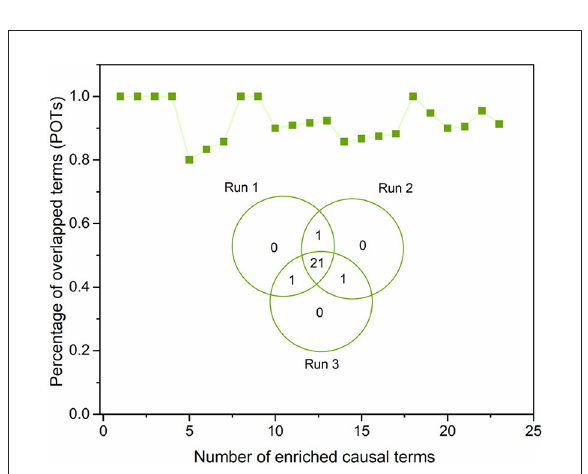
FIGURE7 Robustness evaluation of the proposed DeepCausality: The Venn diagram illustrates the overlapping of the enriched causal terms by three parallel runs. The dotted-line curve illustrates the percentage of overlapping causal terms (POTs) among the three repeated runs across ranked order terms by z scores.